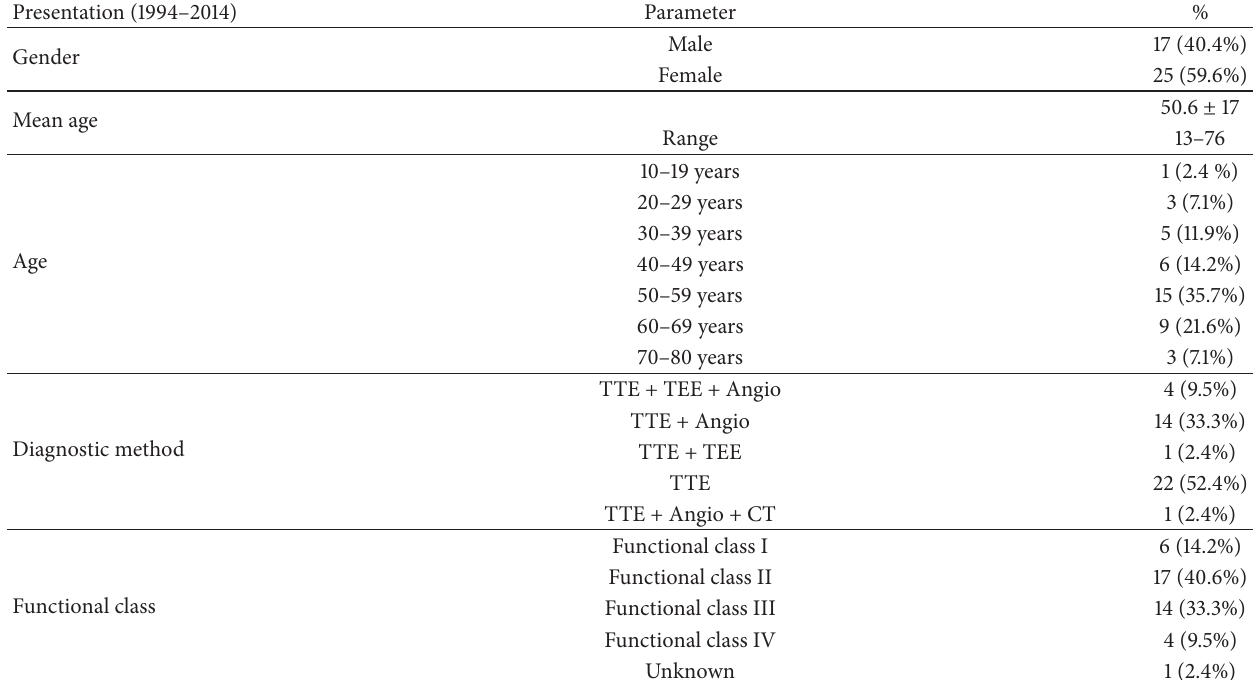
Table 1: Preoperative patients’ information from 1994 to 2014 diagnosed with myxoma in Shahid Modarres Hospital.